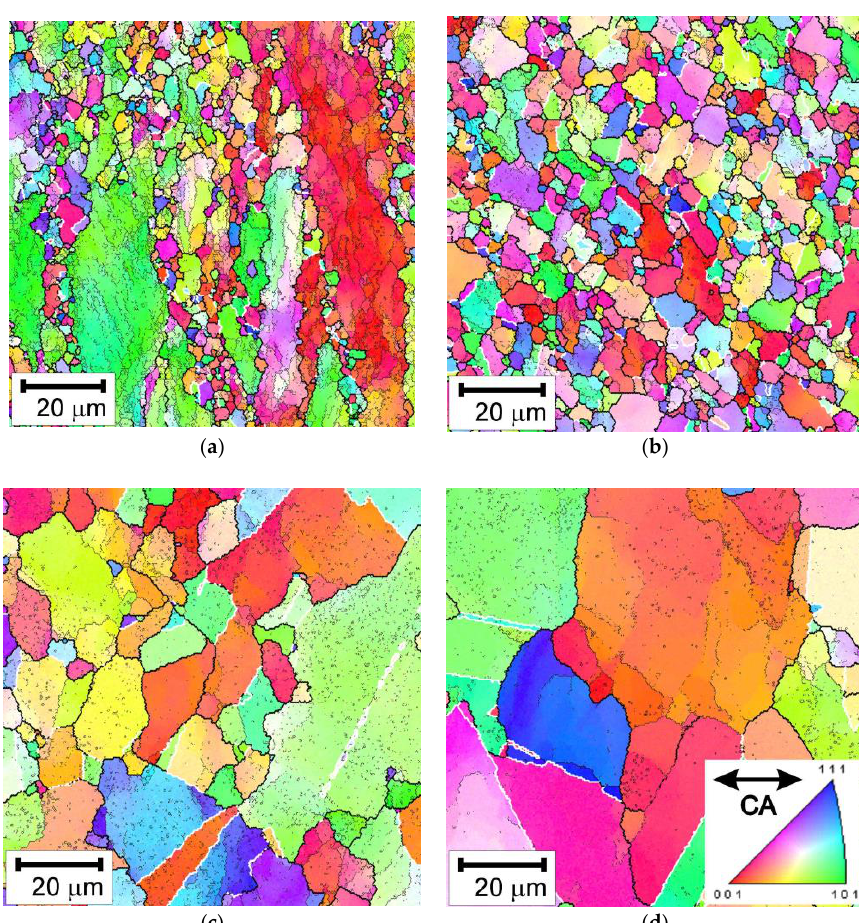
Figure 4. The typical deformation microstructures evolved in a high-Mn steel during hot compression at T = 1073 K and a strain rate of 10 −2 s −1 ( a ); at 1073 K and 10 −3 s −1 ( b ); at 1223 K and 10 −3 s −1 ( c ); and at 1323 K and 10 −3 s −1 ( d ). The colors indicate the orientation along the compression axis (CA). The high-angle boundaries, low-angle sub-boundaries, and twin boundaries are shown by the thick black lines, thin black lines, and white lines, respectively.